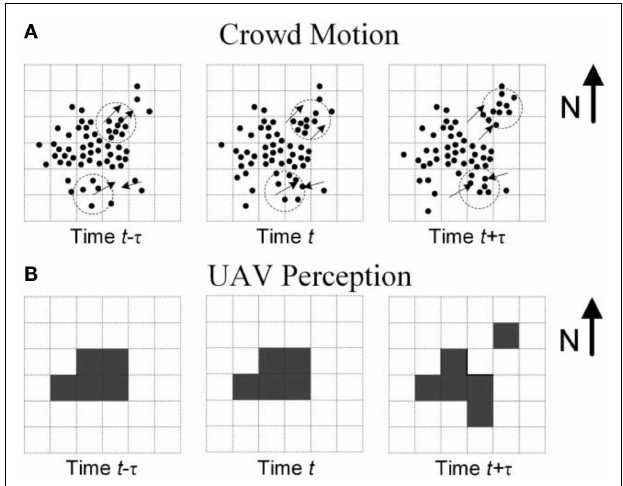
FIGURE 2 | Illustration of crowd motion and UAV detection outcome. (A) Black dots: individuals in simulation case; dashed circle: small groups of individuals; arrow: motion trend of individuals; (B) filled square: occupied cells detected by